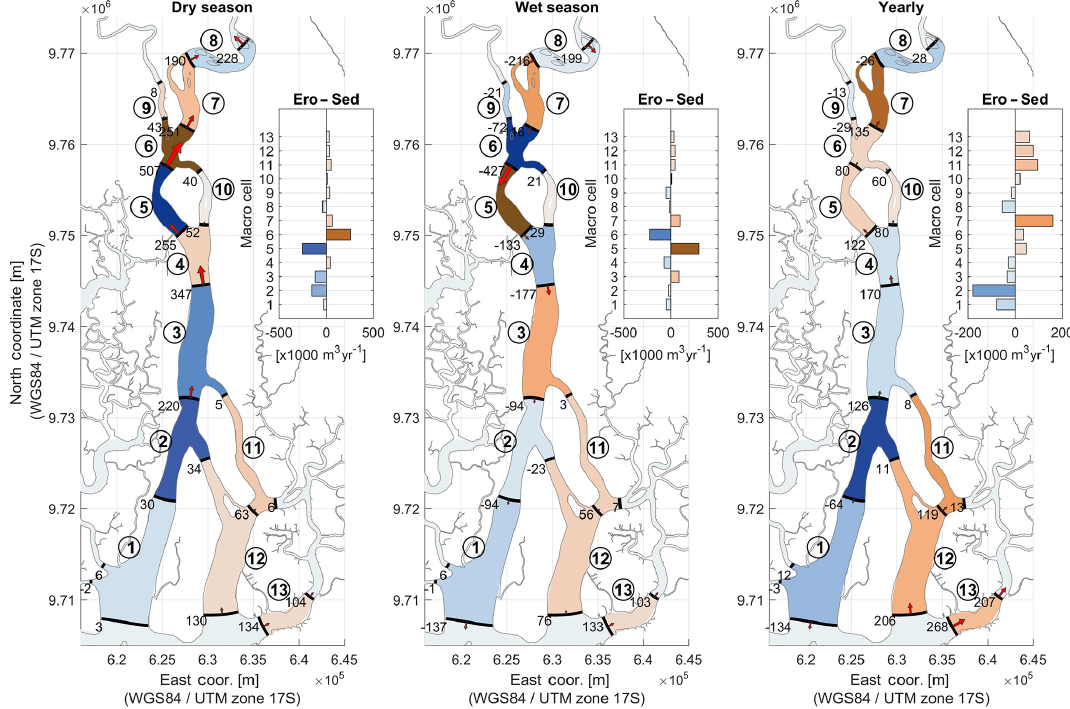
Figure 9. Sediment balance computed yearly and seasonally for the situation prior to the Daule–Peripa Dam project (Case 1).